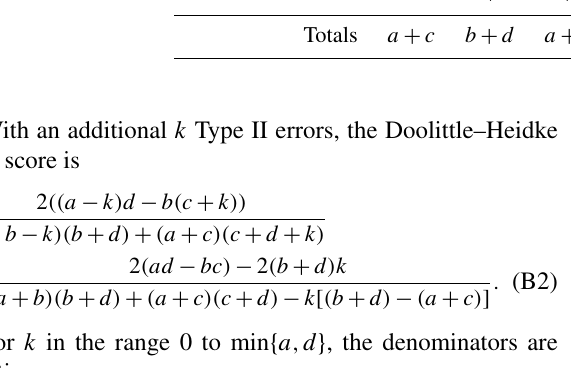
Observed Observed + − Totals + − Totals